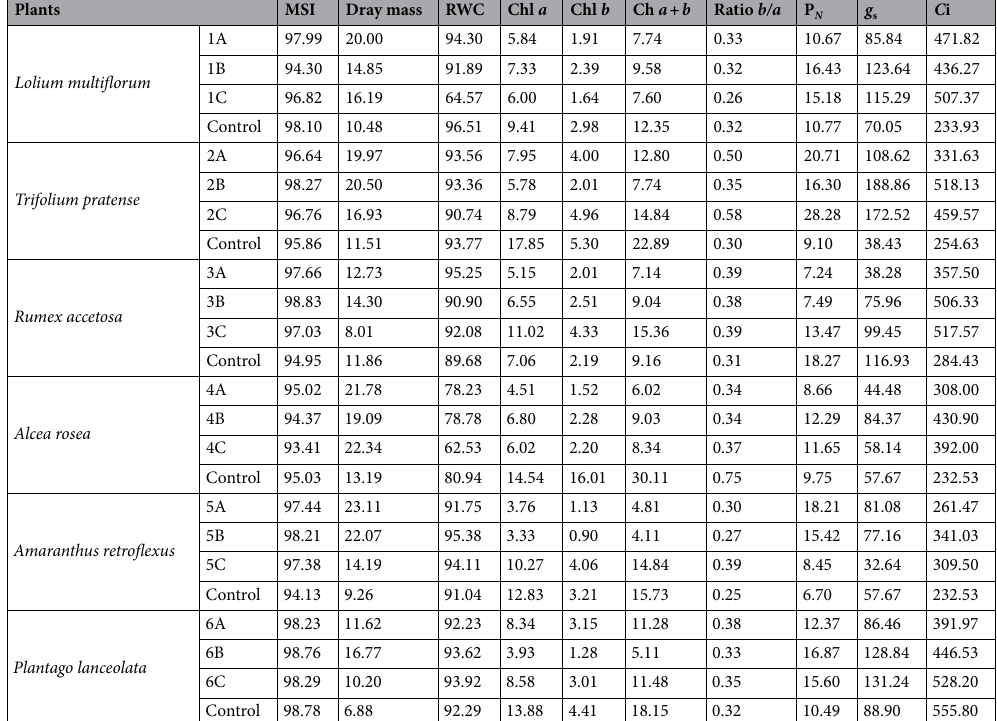
Table 2. Cell membrane stability—MSI (%), dry mass (%), relative water content—RWC (%), chlorophyll [Chl a , Chl b , Chl a + b , ratio b/a ] (mg g −1 ), and photosynthetic activities—net photosynthetic rate— P N (µmol CO 2 m −2 s −1 ) detected for all samples (abbreviations see “Materials and methods”).